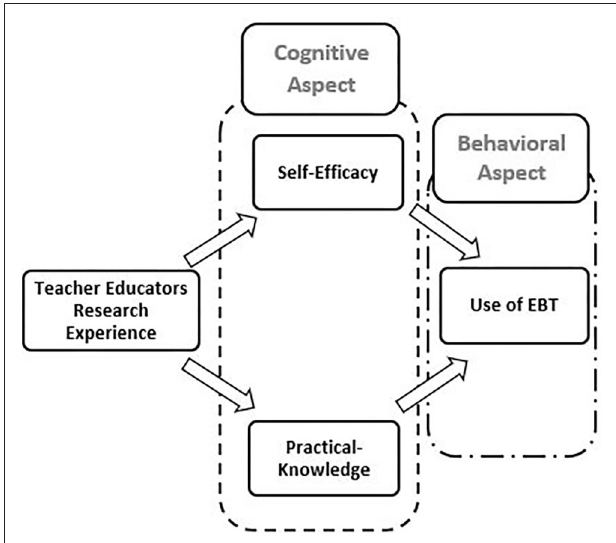
FIGURE 1 | Schematic representation of the hypothesized model based on the theoretical models of Miller (1990) and Bandura